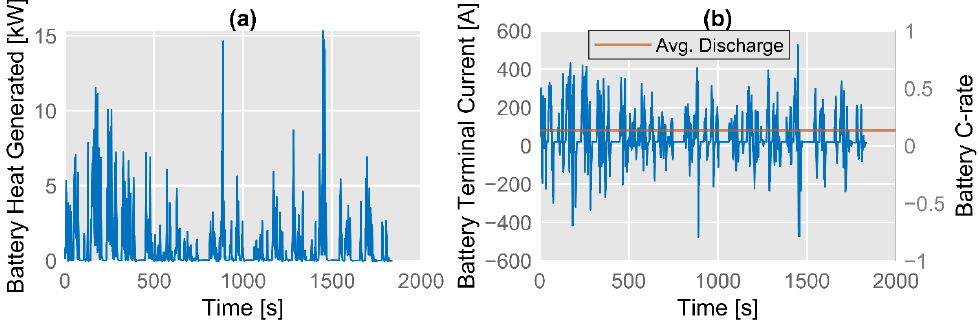
Figure 19. ( a ) Battery heat losses and ( b ) battery terminal current variation throughout time for a one-way journey of the L18.